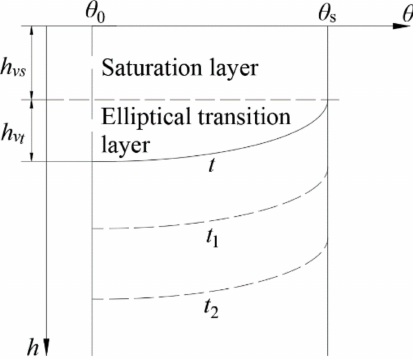
Figure 2. Distribution of the soil water content under